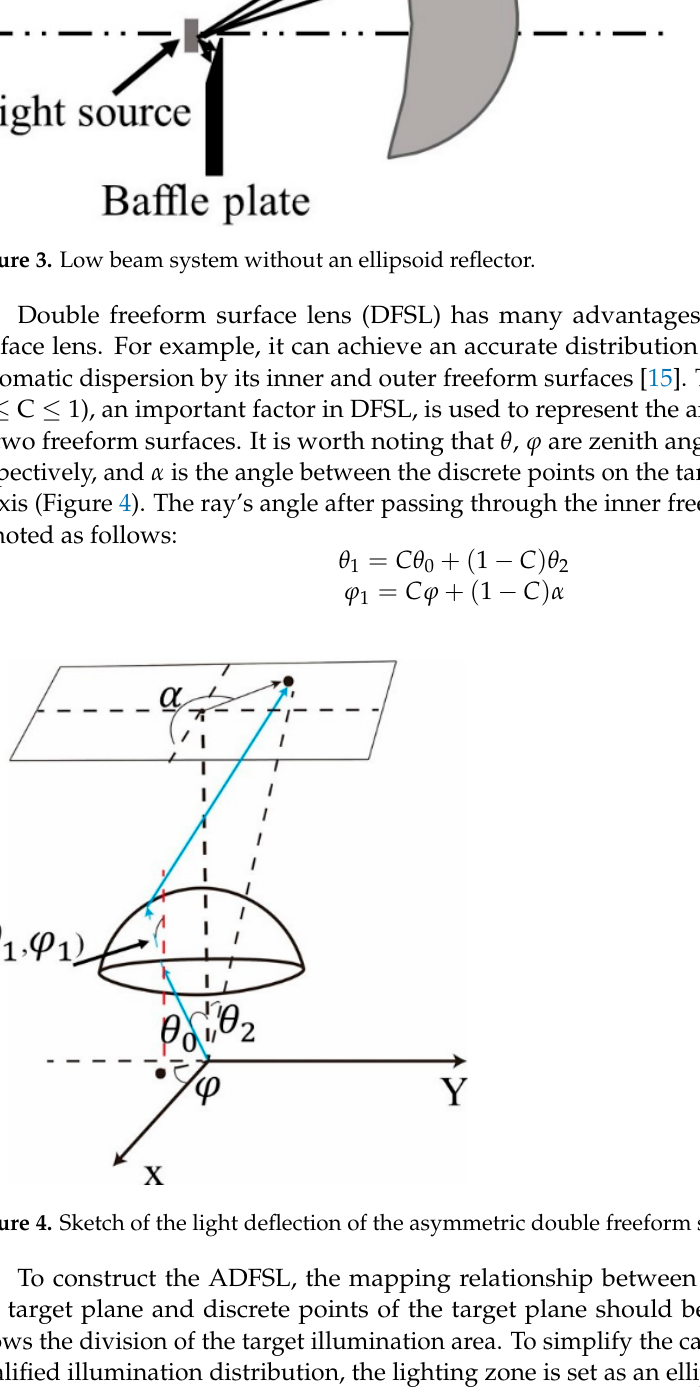
To construct the ADFSL, the mapping relationship between certain angle rays on the target plane and discrete points of the target plane should be calculated. Figure 5 shows the division of the target illumination area. To simplify the calculation and generate qualified illumination distribution, the lighting zone is set as an ellipse and divided into I, II, III zones. E1 , E2 , E3 are the corresponding illuminances of zone I, II, III, respectively, and the semi-major axis is a , and the semi-minor axis, b . Similarly, the semi-major and semi-minor axes are equally divided into three parts, with a i , b i being the semi-major axis and semi-minor axis of the divided sub-ellipse, respectively. On the other hand, the